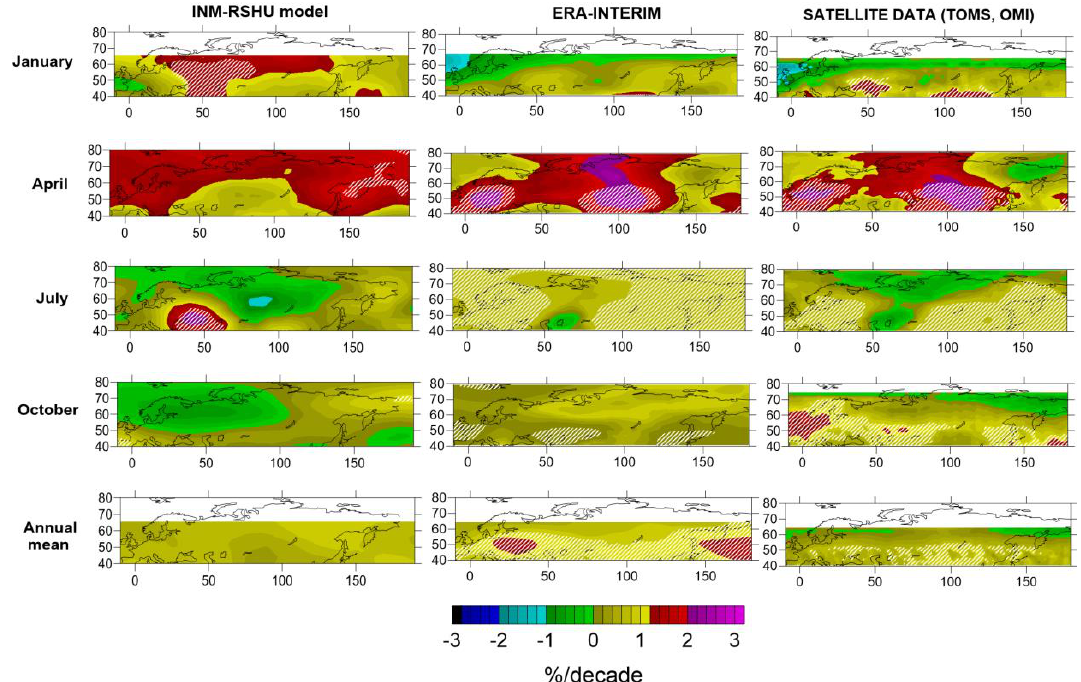
Figure 8. The time series of the Eery relative anomalies against 2000 at 48° N from 0° E to 150° E according to the INM-RSHU CCM, ERA-Interim, and TOMS/OMI satellite datasets.